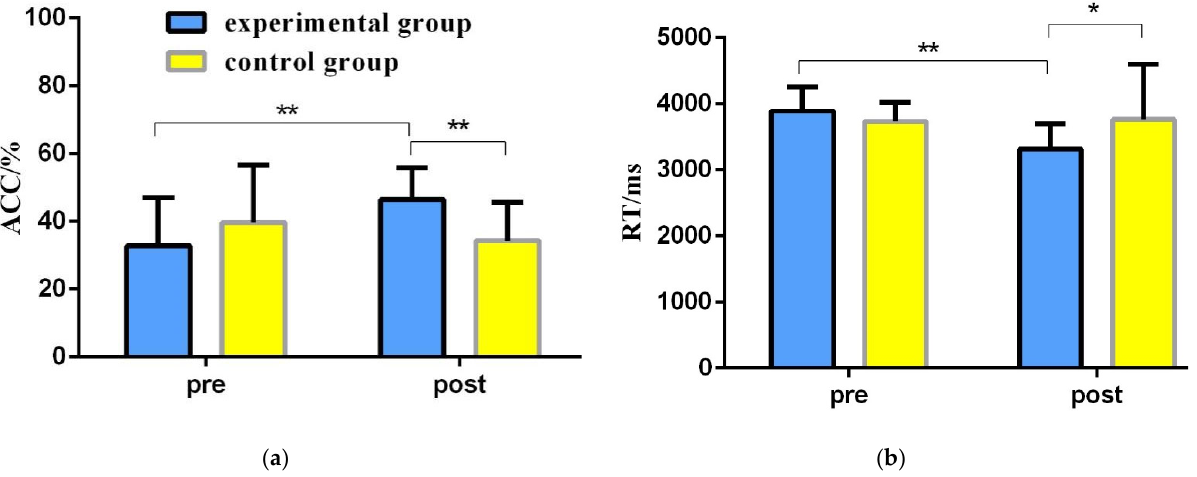
Figure 5. Changes in behavioral results of the experimental group and the control group before and after exercise intervention. ( a ) Changes in the correct rate of spatial memory test before and after the orienteering intervention in the experimental and control groups; ( b ) changes in the response time of spatial memory test before and after the orienteering intervention in the experimental and control groups; blue represents the experimental group, yellow represents the control group. * 0.01 < p < 0.05; ** p < 0.01.